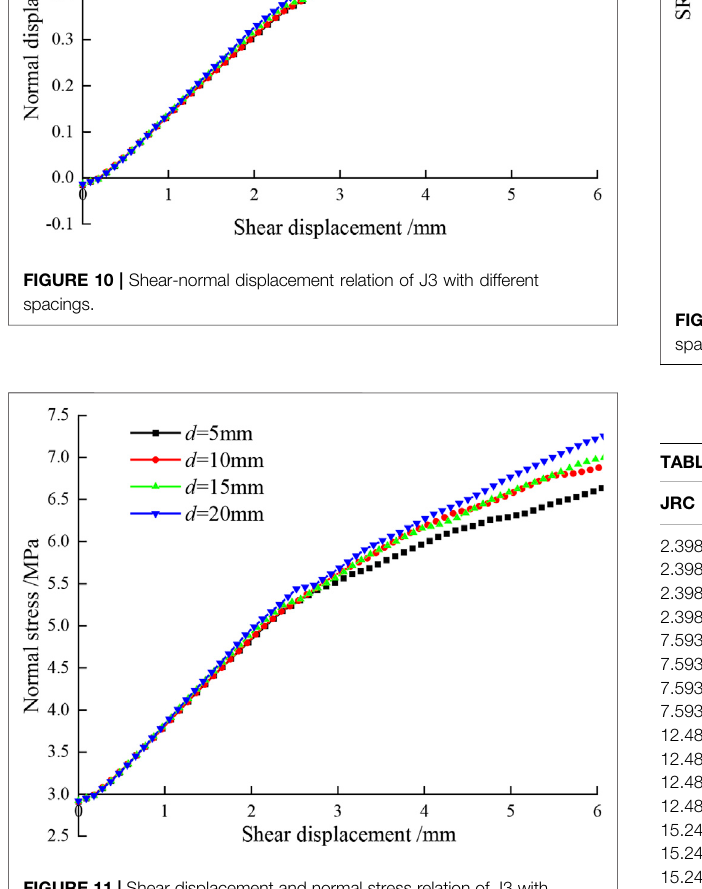
FIGURE 11 | Shear displacement and normal stress relation of J3 with different spacings.